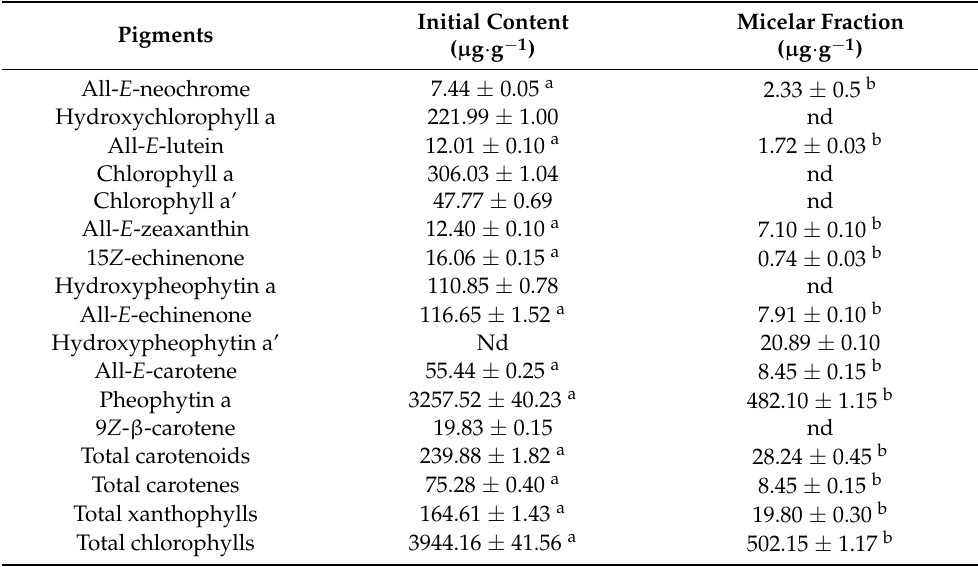
Table 2. Pigment content of C. calcitrans before in vitro digestion (initial content), and the micellar fraction of carotenoids from ultrasonicated biomass after in vitro digestion. Different letters in the lines indicate a significant difference using Student’s t -test ( p <